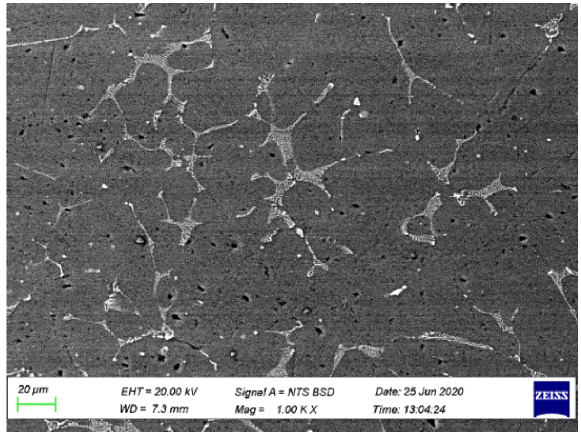
Figure 5: SEM-BSE image of As-cast Al 6063/6 wt.% steel p compos-